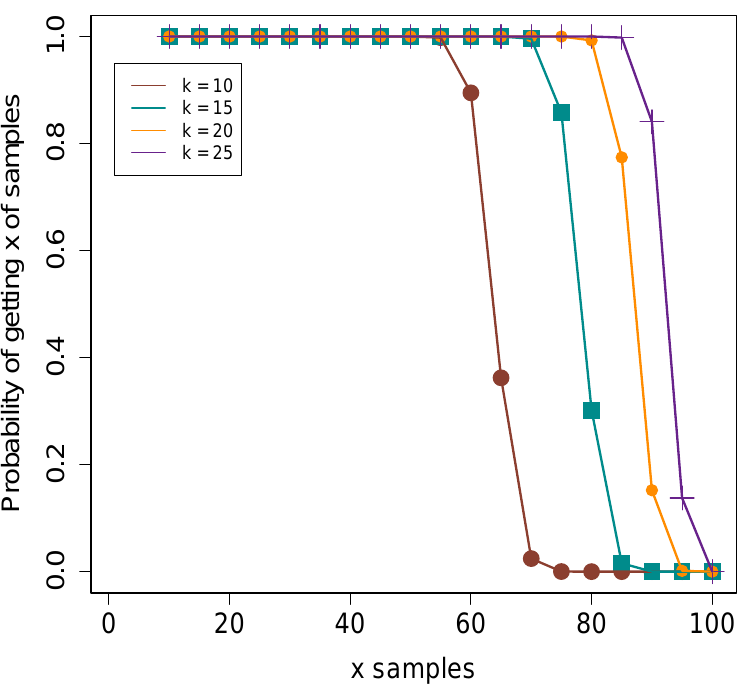
Figure 11. In a database of n = 100 portions and v = 10 free samples per consumer, this graphic depicts the probability of getting a different portion of samples for free with several identities: k = 10 (large red circles), k = 15 (blue squares), k = 20 (small orange circles), k = 25 (purple